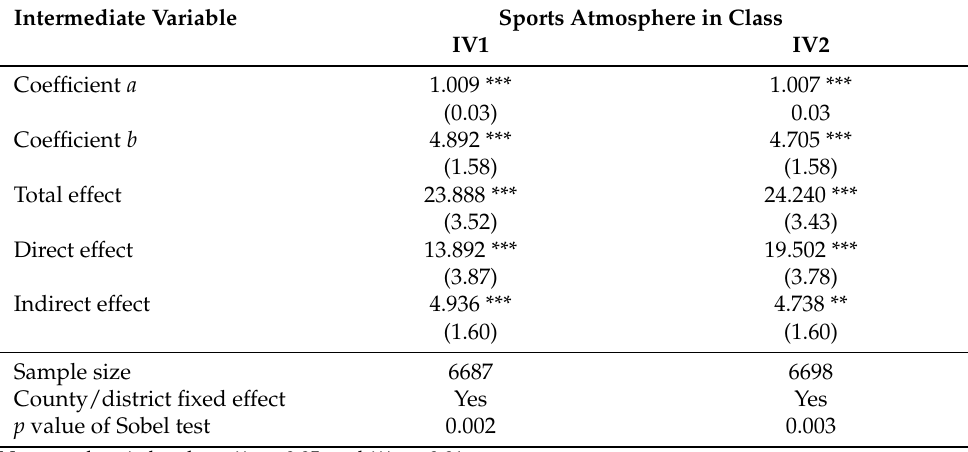
Table 4. Analysis of Intermediary Effect of Sport Atmosphere in